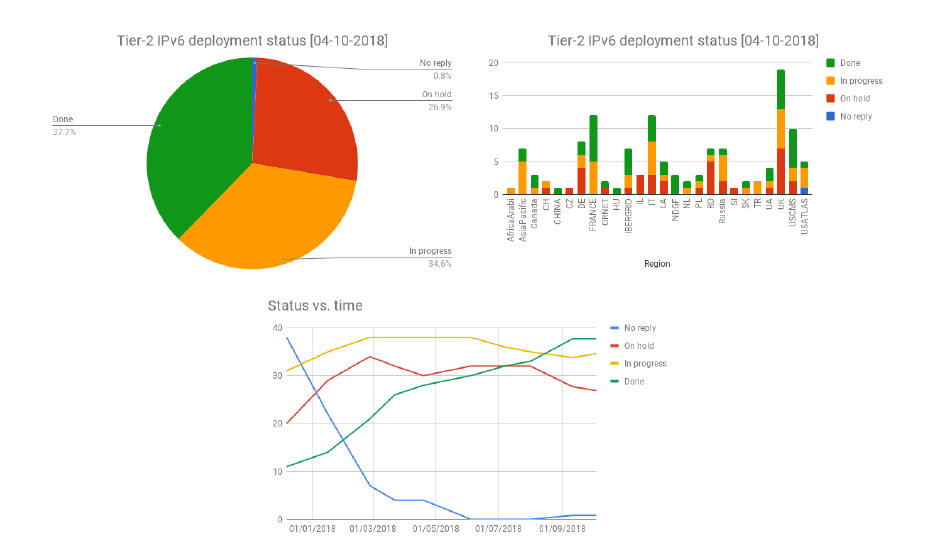
Figure 3. (left) Tier-2 deployment status by site globally, (right) by region, and (bottom) time evolution